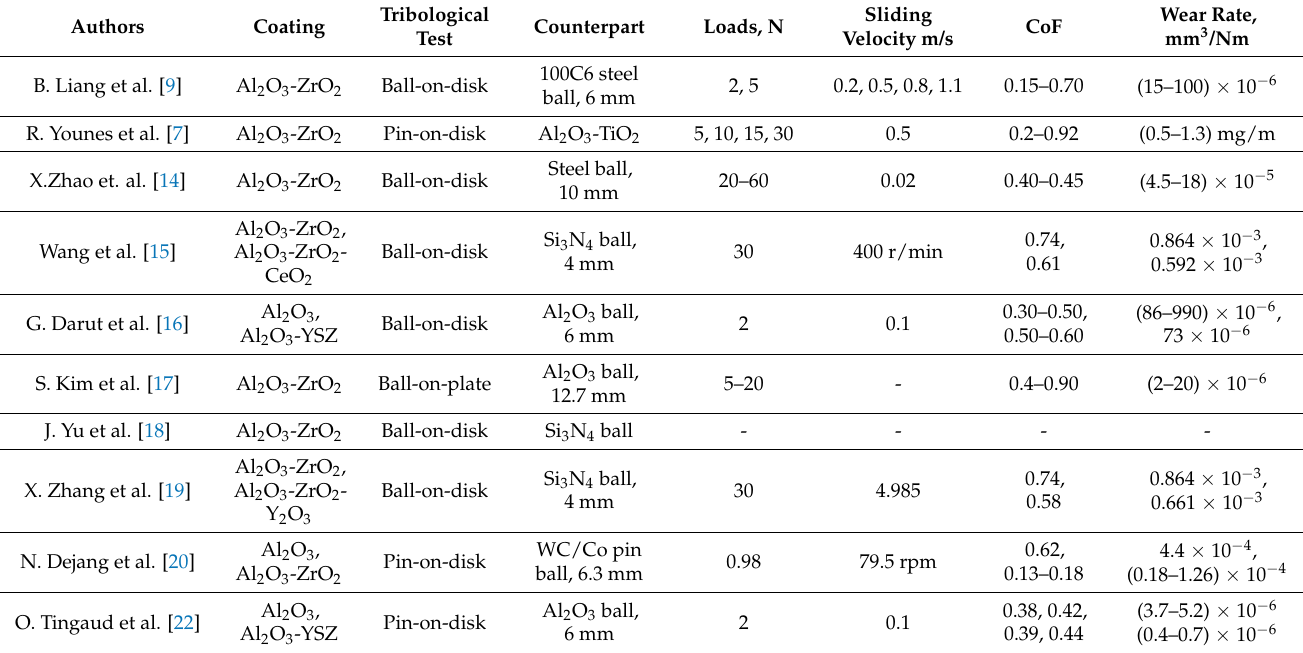
Table 1. Tribological test parameters and properties of various